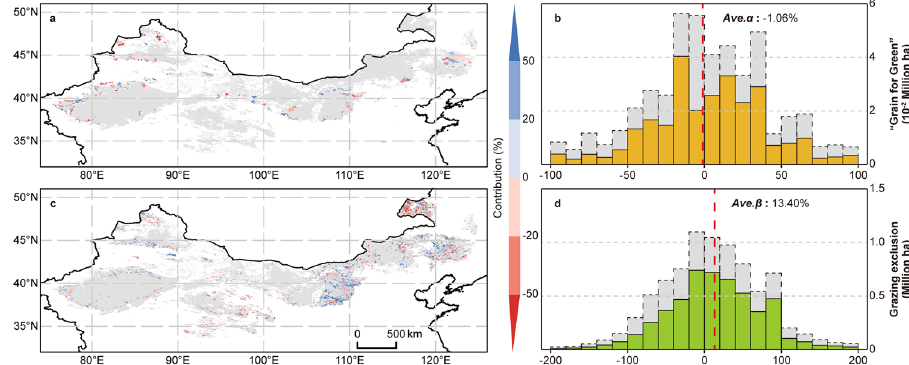
Fig. 1 | The contributions of deserti fi cation-combating practices to vegetation restoration. Spatial and statistical distributions of the contributions (%) of “ grain- for-green ” a , b and grazing exclusion c , d practices to vegetation restoration since 2000and2003,respectively.Thex-axisin b , d correspondstothecontributionsin a , c . The scopeofthe deserti fi cation-prone regionismarked inpanels a and c with gray. For each pixel in a , c , the average fractional vegetation cover (FVC) trend resulting from climate change and CO 2 fertilization (natural FVC trends) isderived by satellite and multiple linear regression simulations, while the contributions of intervention practices are estimated based on the average difference between the natural FVC trend and the actual trend involving practices implementation. Ave. α